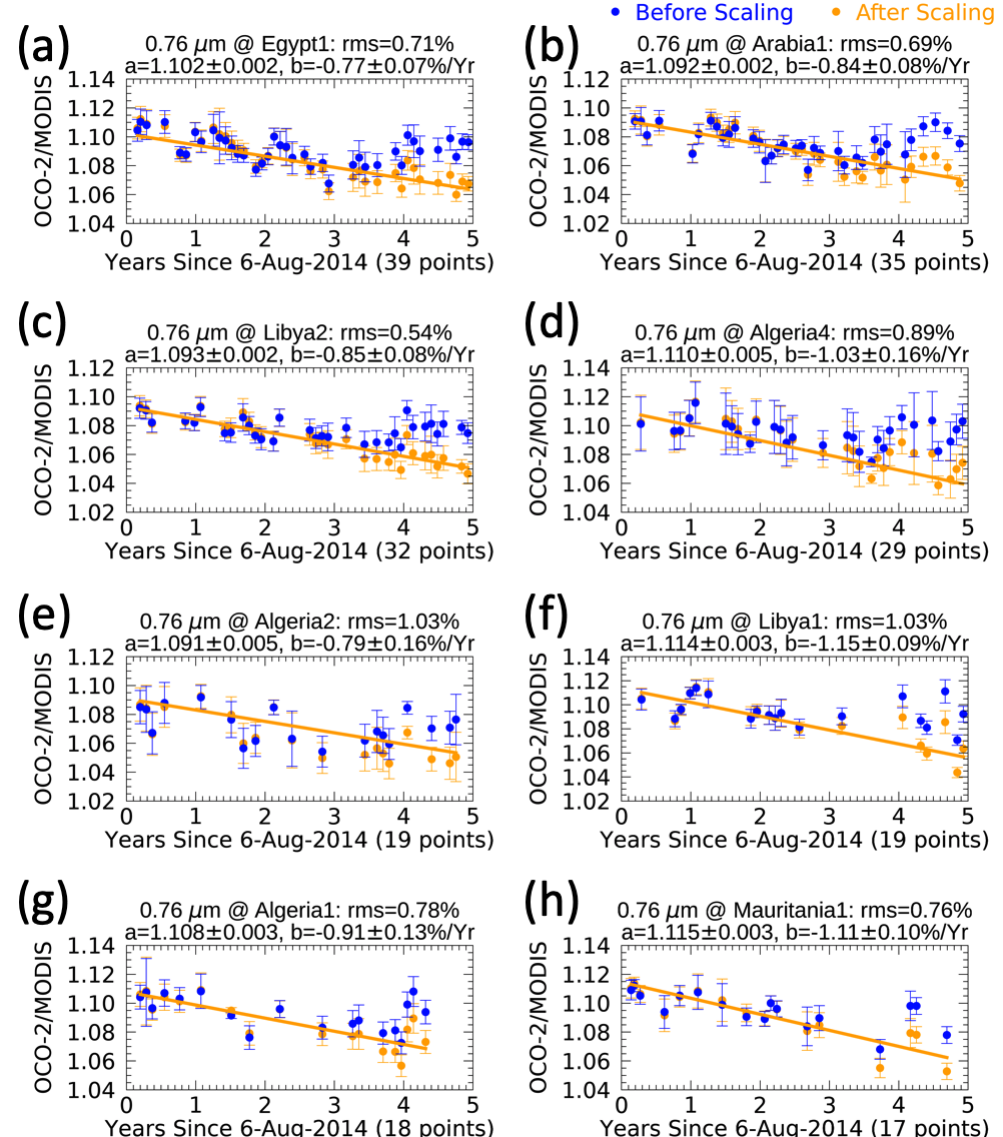
Figure 6. Five-year time seriesof the OCO-2/MODIS radiance ratio for OCO-2 Band 1 over eight desert sites: Panel ( a ) is over Egypt1; Panel ( b ) over Arabia1; Panel ( c ) over Libya2; Panel ( d ) over Algeria4; Panel ( e ) over Algeria2; Panel ( f ) over Libya1; Panel ( g ) over Algeria1; Panel ( h ) over Mauritania1. Orange data points denote the result corrected for an error on modeling the aging of the solar